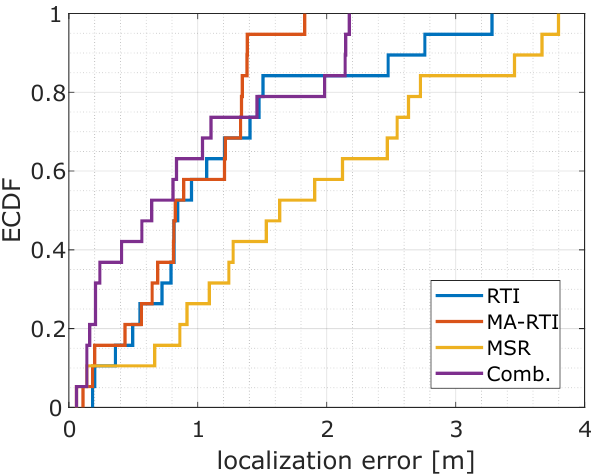
Figure 16. ECDFs of the localization